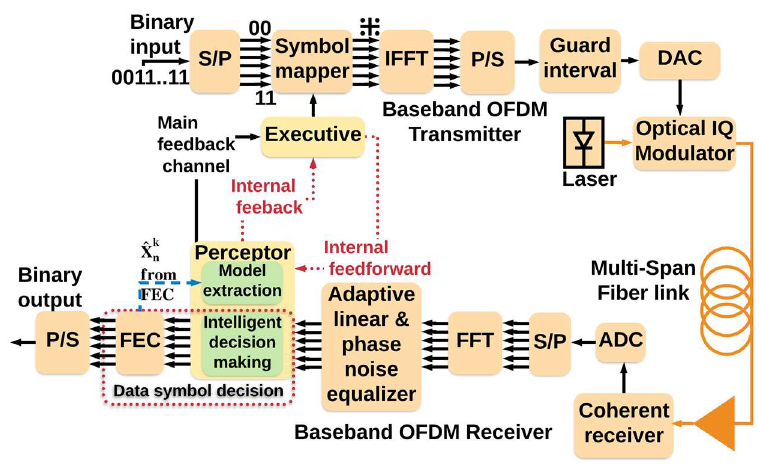
Figure 14. The OFDM-based fiber optic system with simplified CDS.